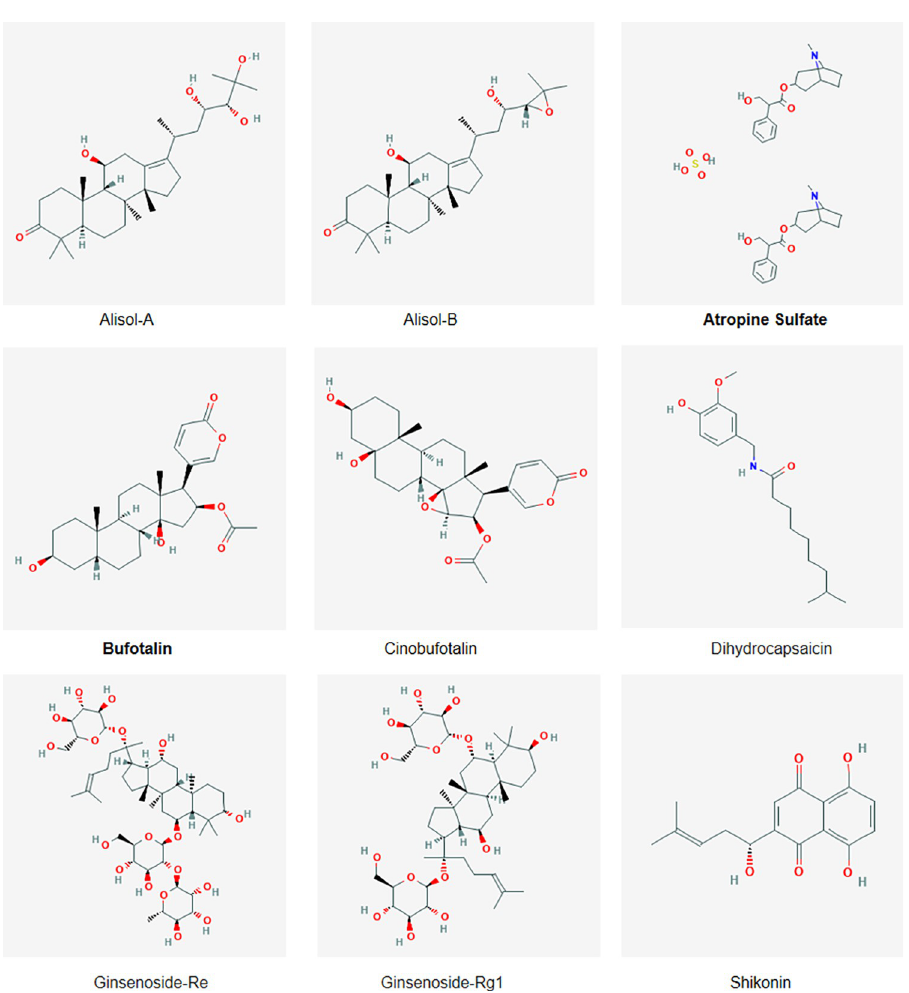
Fig 2. Chemical structures of the hit compounds. The nine compounds identified in the primary in vitro screen using 1 μ M as the highest concentration. The most effective compounds are indicated by boldface letters. These compound structures were obtained from PubChem